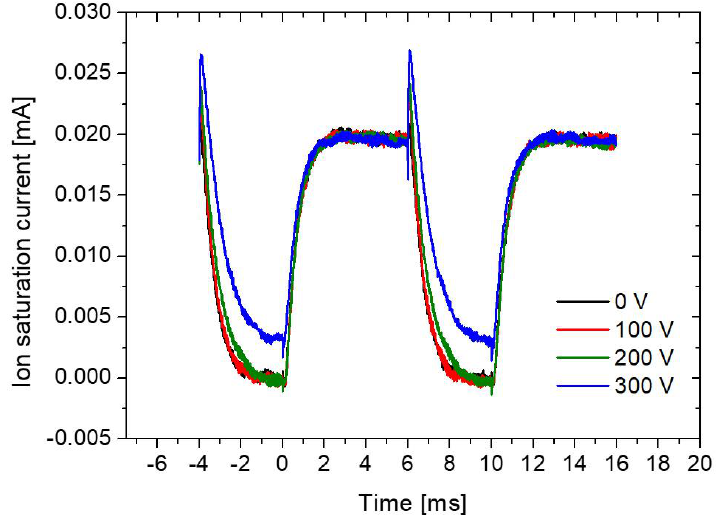
Figure 3. Ion saturation currents measured using a Langmuir probe for various extractor voltages under a constant sputter voltage of −550 V as a function of time.